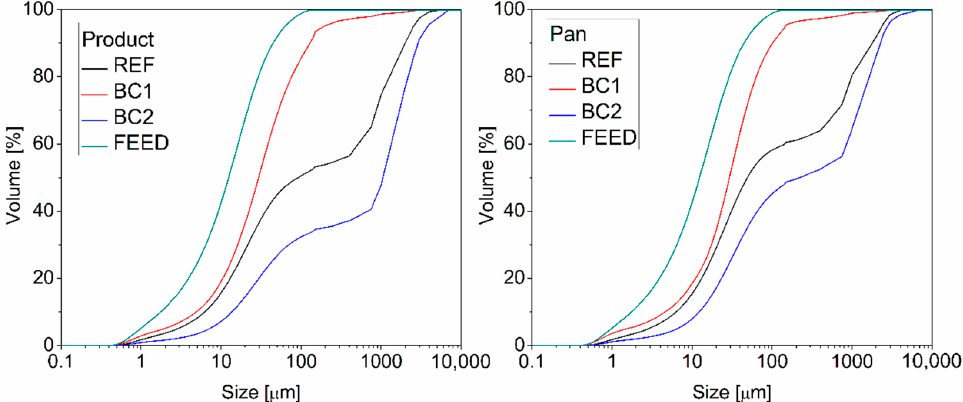
Figure 7. Influence of the binder flow on PSD of product and pan samples of the granulation.